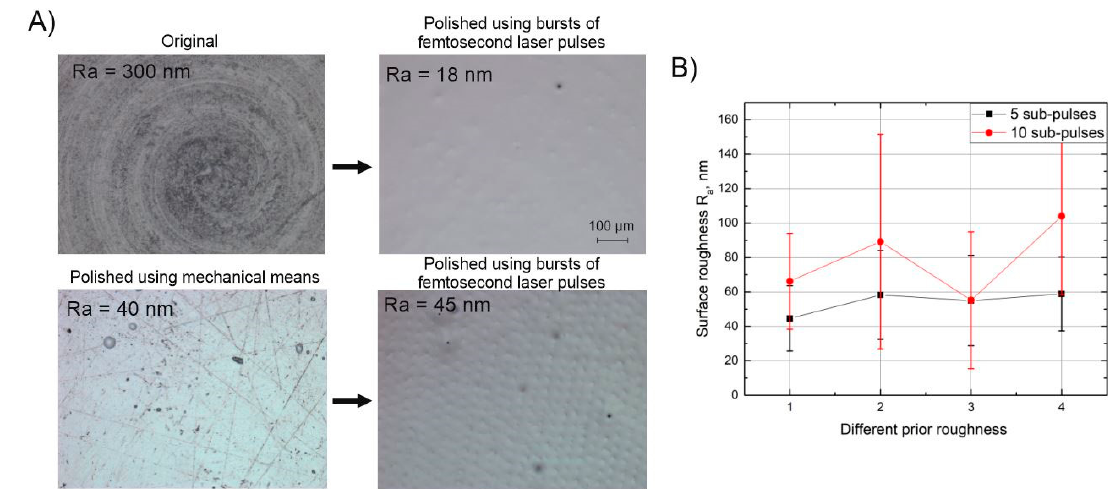
Figure 9. Pre-polished and original samples after polishing using bursts of femtosecond laser pulses ( A ), surface roughness after polishing using bursts of femtosecond laser pulses dependent on the di ff erent prior roughnesses when N p = 5 and N p = 20 ( B ). Parameters used in ( A ) section are: P = 22 W, N p = 5, v = 620 mm / s, dx = 10 µ m, f = 100 kHz and number of scans = 2. Parameters used in ( B ) section are: P = 32 W, v = 700 mm / s, dx = 10 µ m, f = 100 kHz and number of scans = 2.